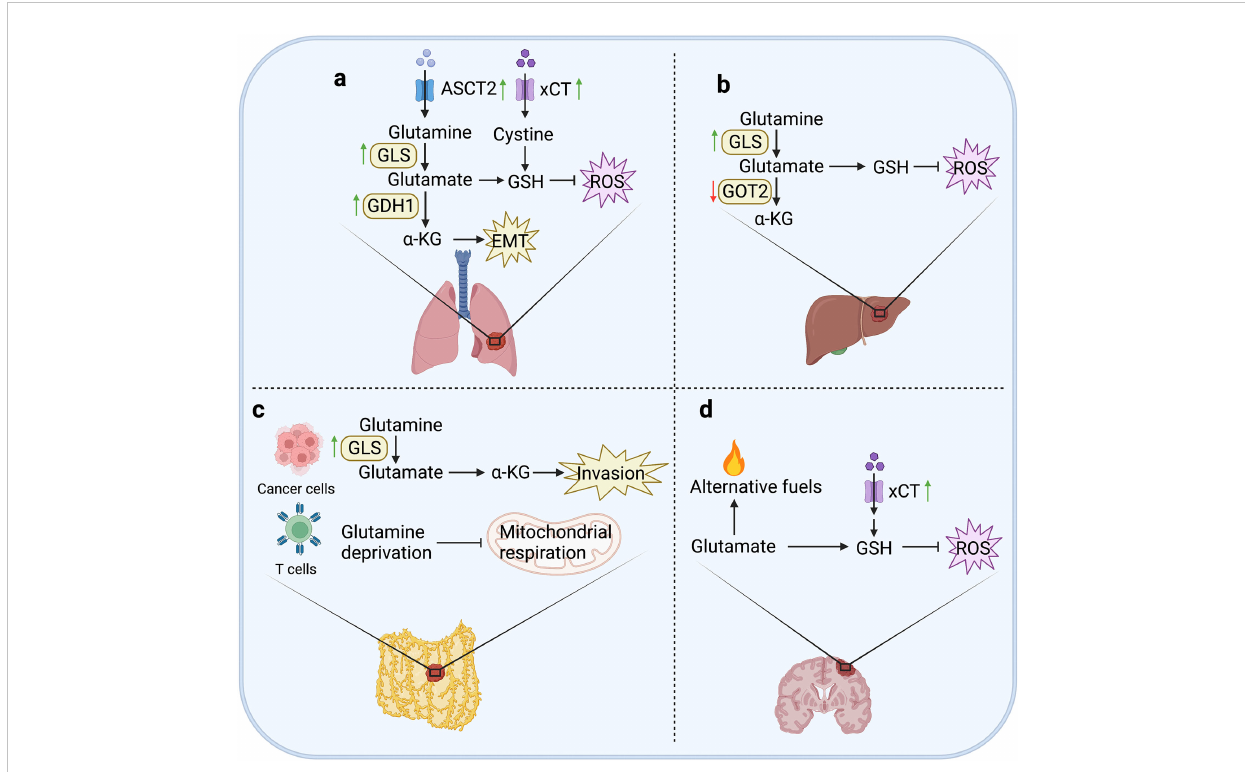
FIGURE 2 Glutamine metabolism in tumor metastases. (A) In lung, the expression of ASCT2 can maintain the intracellular glutamine level by seizing in the microenvironment. Upregulation of GLS1 in CRC cells can enhance glutamine metabolism to promote the formation of lung metastases. The expression of GDH1 contributes to anoikis resistance and pro-metastatic signals in LKB1-de fi cient lung metastasis. xCT can promote cystine uptake to increase the generation of GSH to constrain ROS levels, and enhance the invasiveness of breast cancer cells. (B) In liver, the expression of GLS1 can generate GSH to attenuate ROS accumulation. However, knockdown of GOT2 can promote hematogenous and intrahepatic metastasis of HCC cells. (C) In peritoneum, upregulated GLS1 expression is closely related to high invasiveness of OvCa cells. Moreover, glutamine metabolism can perturb T cell mitochondrial respiration to induce immune evasion of OvCa cells. (D) In brain, glutamine can be used as an alternative fuel to avoid energy de fi ciency in metastatic cells. In addition, the expression of ASCT2 is upregulated in human glioma cells, and overexpression of xCT can resist oxidative stress to promote metabolic adaptation of brain metastasis in breast cancer